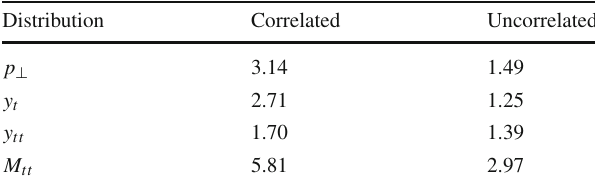
Fig. 9 Impact of the ATLAS 8 TeV dilepton data on the gluon PDF, for the y tt and M tt distributions Table 6 χ 2 / N data values for fits to the CMS 8 TeV lepton + jets data with the systematic errors taken as correlated and uncorrelated, as described in the text Distribution